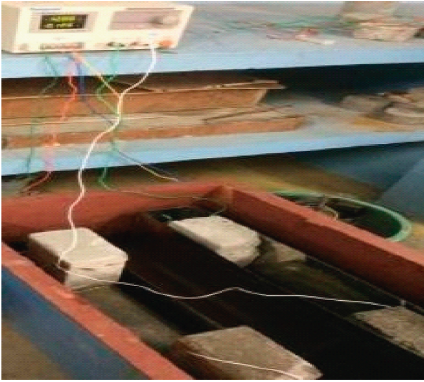
Figure 5: Accelerated corrosion test setup.